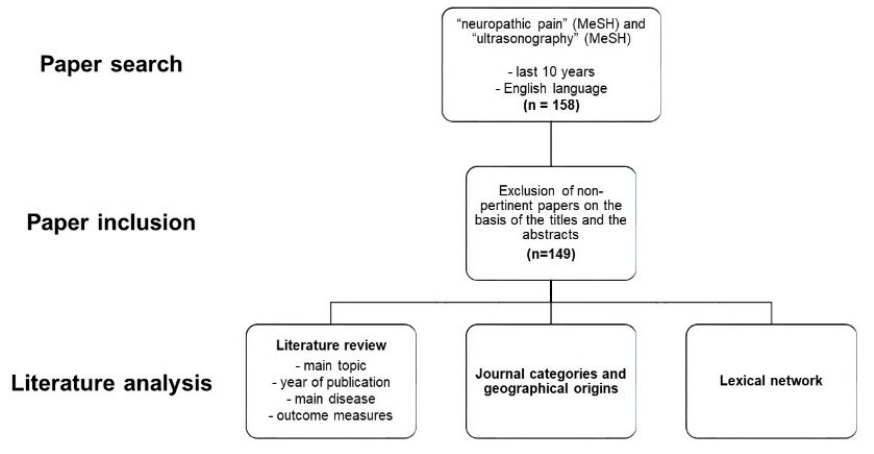
Figure 2. Flowchart of the literature